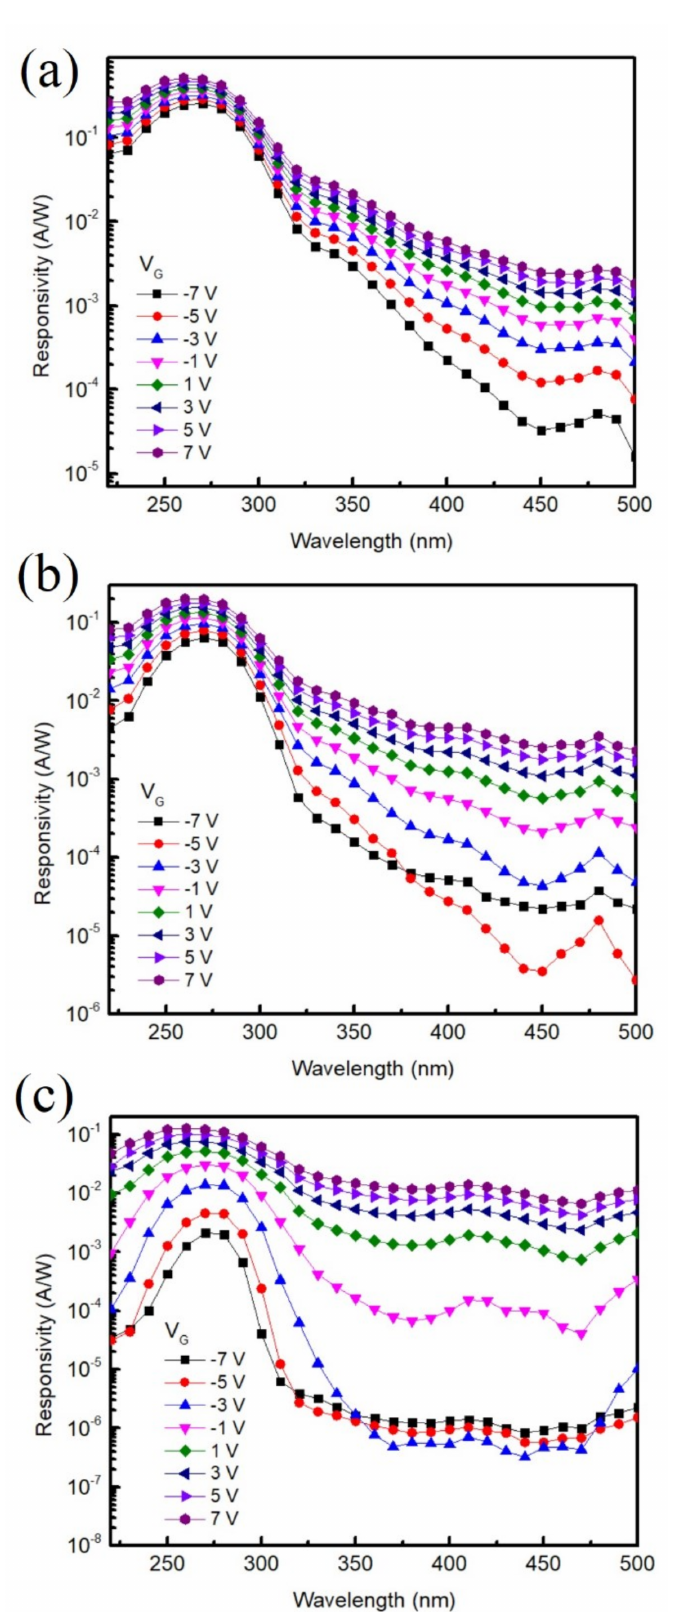
Figure 6. Responsivity of PTFTs sputtered with power ratios of AGO:ZnO equal to ( a ) 20:60; ( b ) 40:60; and ( c )